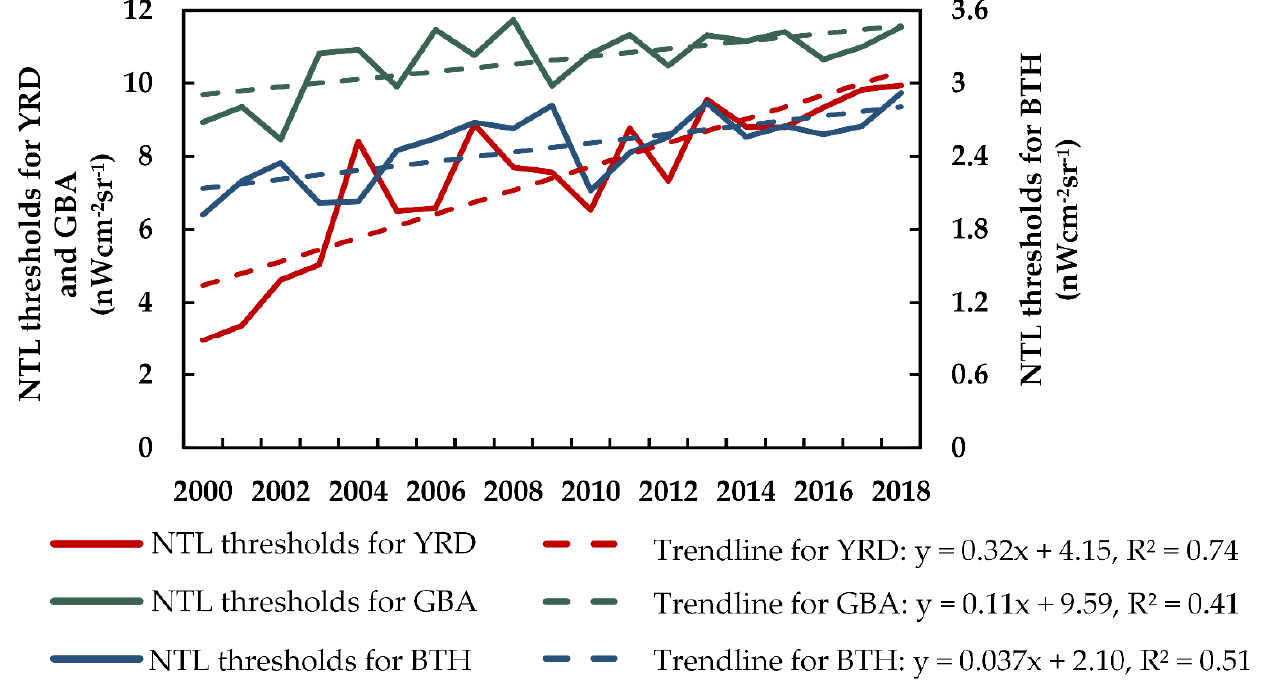
Figure 4. The dynamics of thresholds and linear trends from 2000 to 2018 in the three urban agglomerations. In the equation, y denotes the thresholds, and x denotes the year.